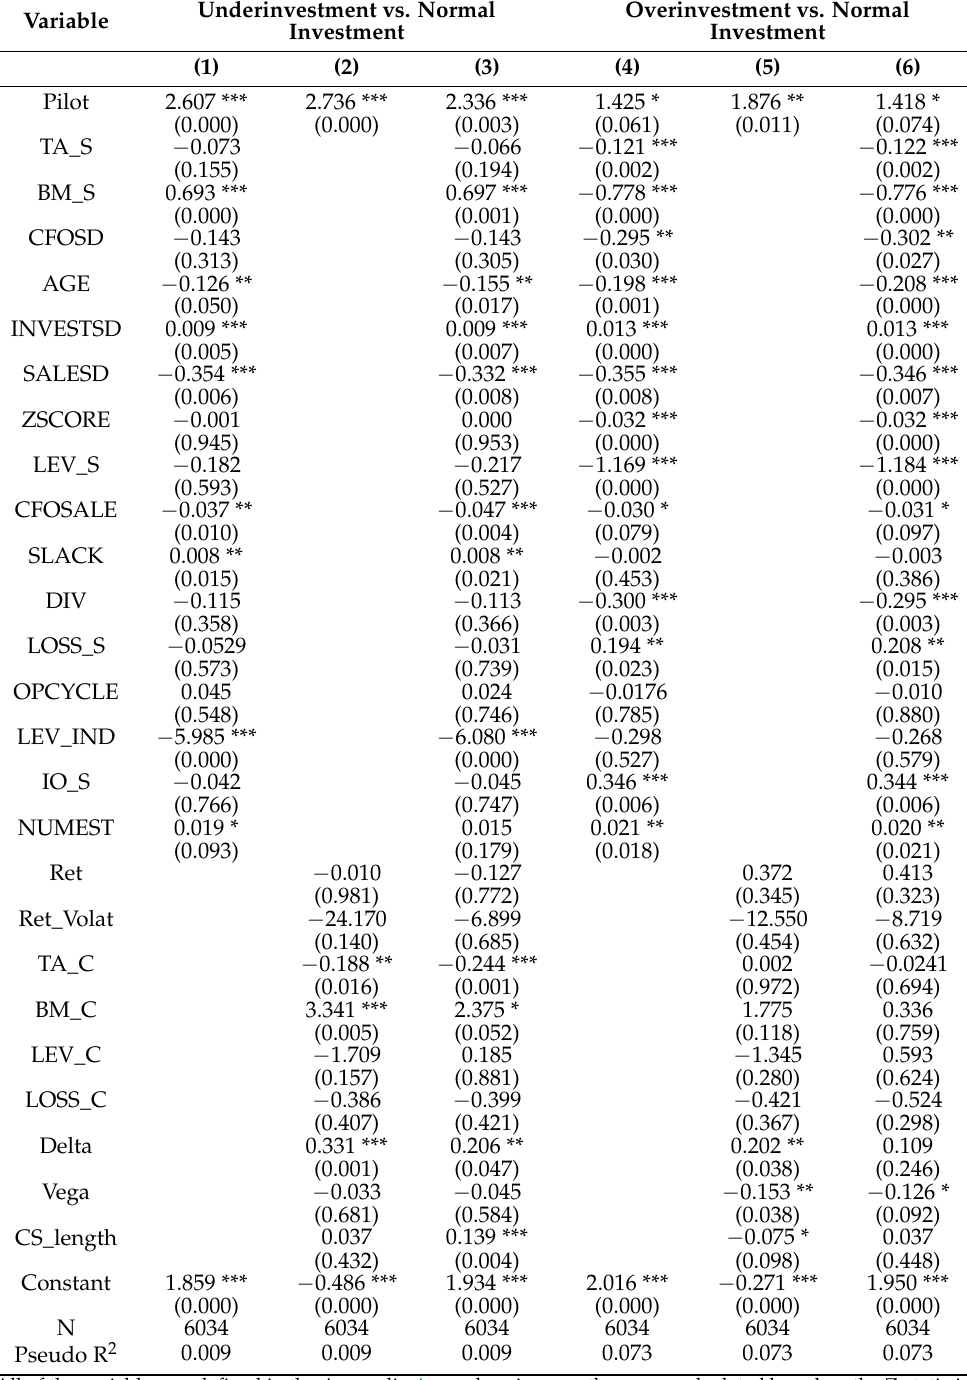
Table 3. Main regression